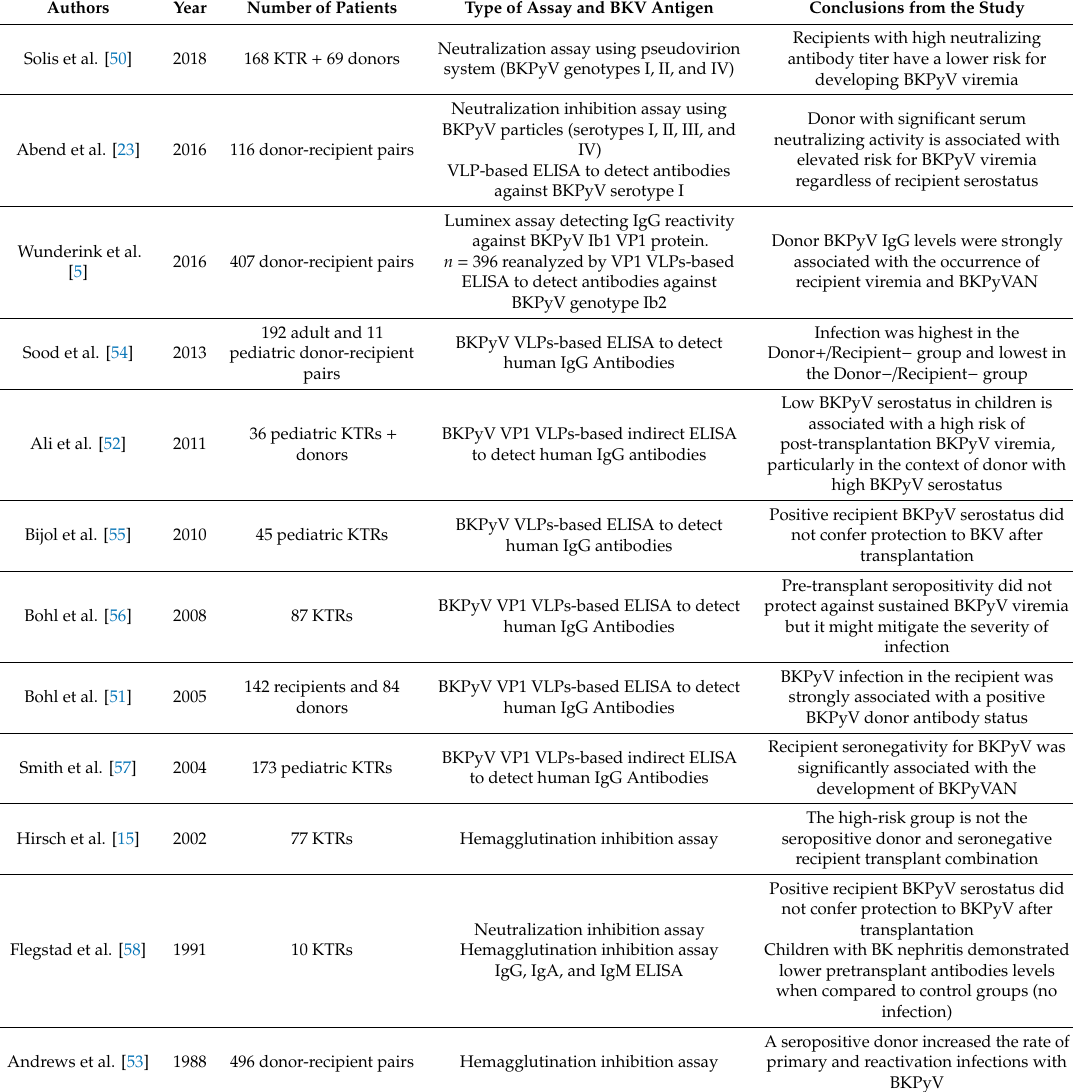
Table 2. An overview of the di ff erent research studies pertaining to the involvement of pre-transplant BKPyV serology testing in post-transplantation BKPyV